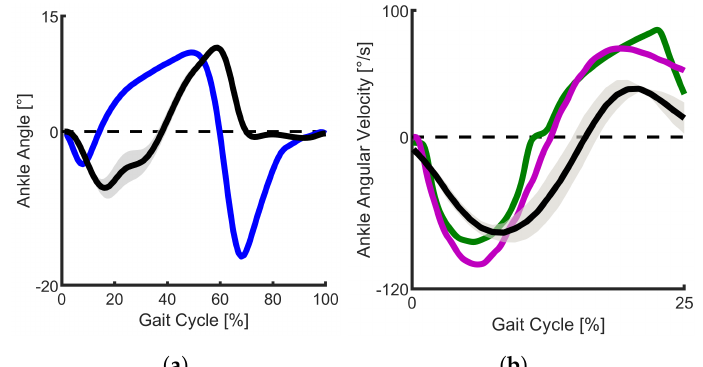
Figure 9. Subject with transtibial amputation level-ground walking experiments using the H2AP, including ankle angle and ankle angular velocity. Prosthetic limb data include the mean and standard deviations of multiple strides. ( a ) comparison of the ankle angle during one gait cycle between the prosthetic limb (black, 1.01m/s) and the reference data (blue, 1.1m/s). The zero angle is the ankle angle at heel strike; ( b ) comparison of the ankle angular velocity during 25% of the gait cycle between the prosthetic limb (black, 1.01m/s), simulated model (green, 1.1m/s), and ideal damper velocity (purple,